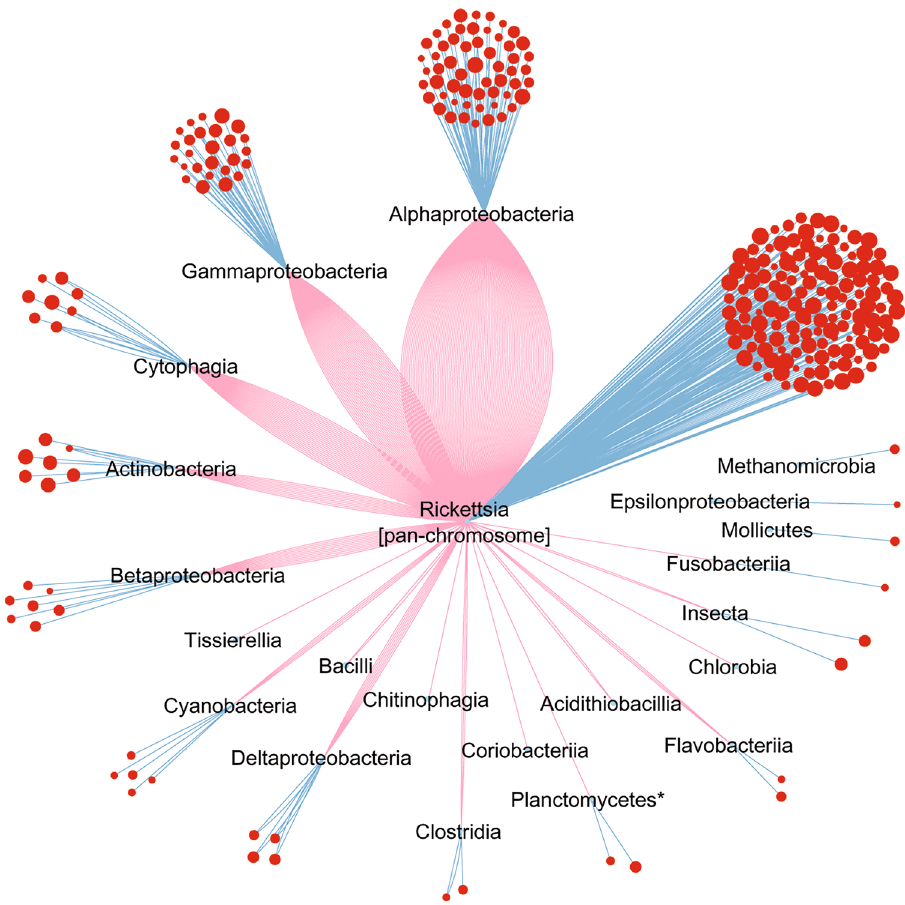
Figure 7. Evolutionary network of the Rickettsia pan-plasmidome exhibiting homologues from the Rickettsia pan-chromosome and customised databases containing non- Rickettsia protein sequences of bacteria, archaea, eukarya and viruses. Nodes represent the flexible pan-plasmidome pRiGs (in red). Node sizes refer to sequence identities (from 30 to 100%) between a pRiG and its first best homologue (blue edges). Some pRiGs also displayed second best homologues (red